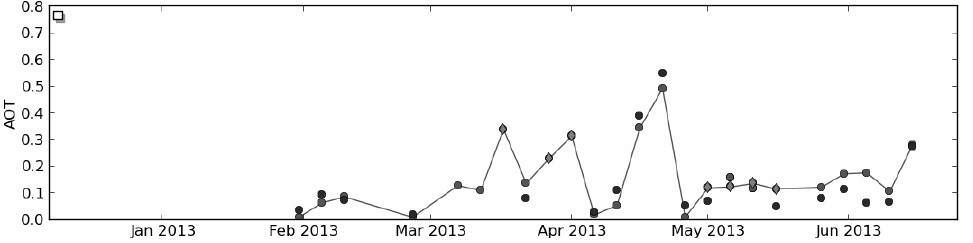
Figure 8. Comparison of MACCS aerosol optical thickness (AOT) estimates at 550 nm (lines) with the AOT measured in situ on the AeroNet site in Ouarzazate (Morocco) (dots), as a function of